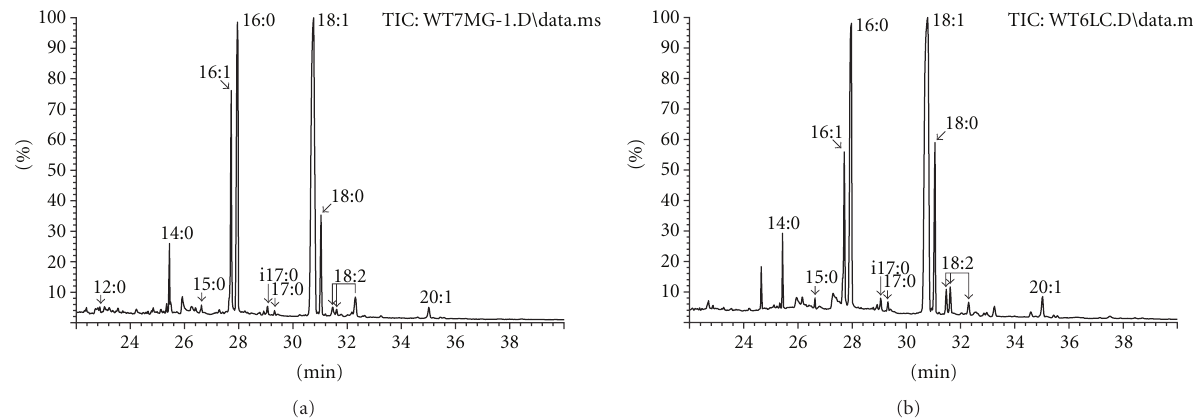
Figure 3: Chromatograms of fatty acid derivatives formed during the thermolysis in the presence of TMAH of deep-frozen (a) and lyophilized (b) bone.